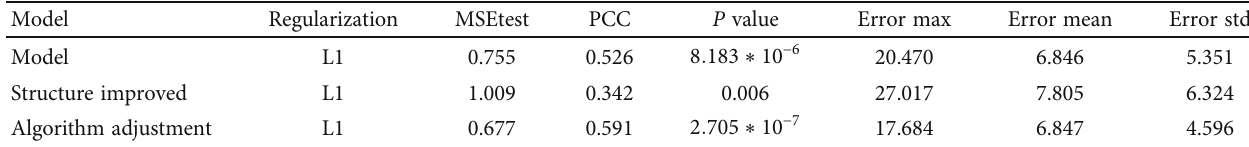
Table 3: Evaluation of 3 models under L1